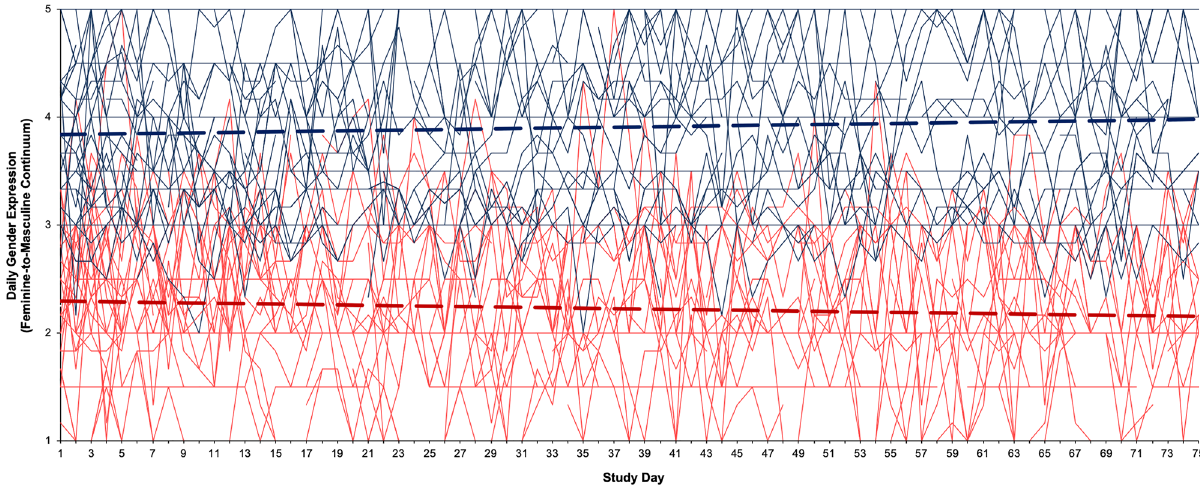
Figure 1. Line graph of daily gender expression (feminine-to-masculine continuum) for individual men (thin blue lines) and women (thin red lines) across the 75 days of the intensive longitudinal study. Thick dashed lines show trends averaging across participants of the same self-reported